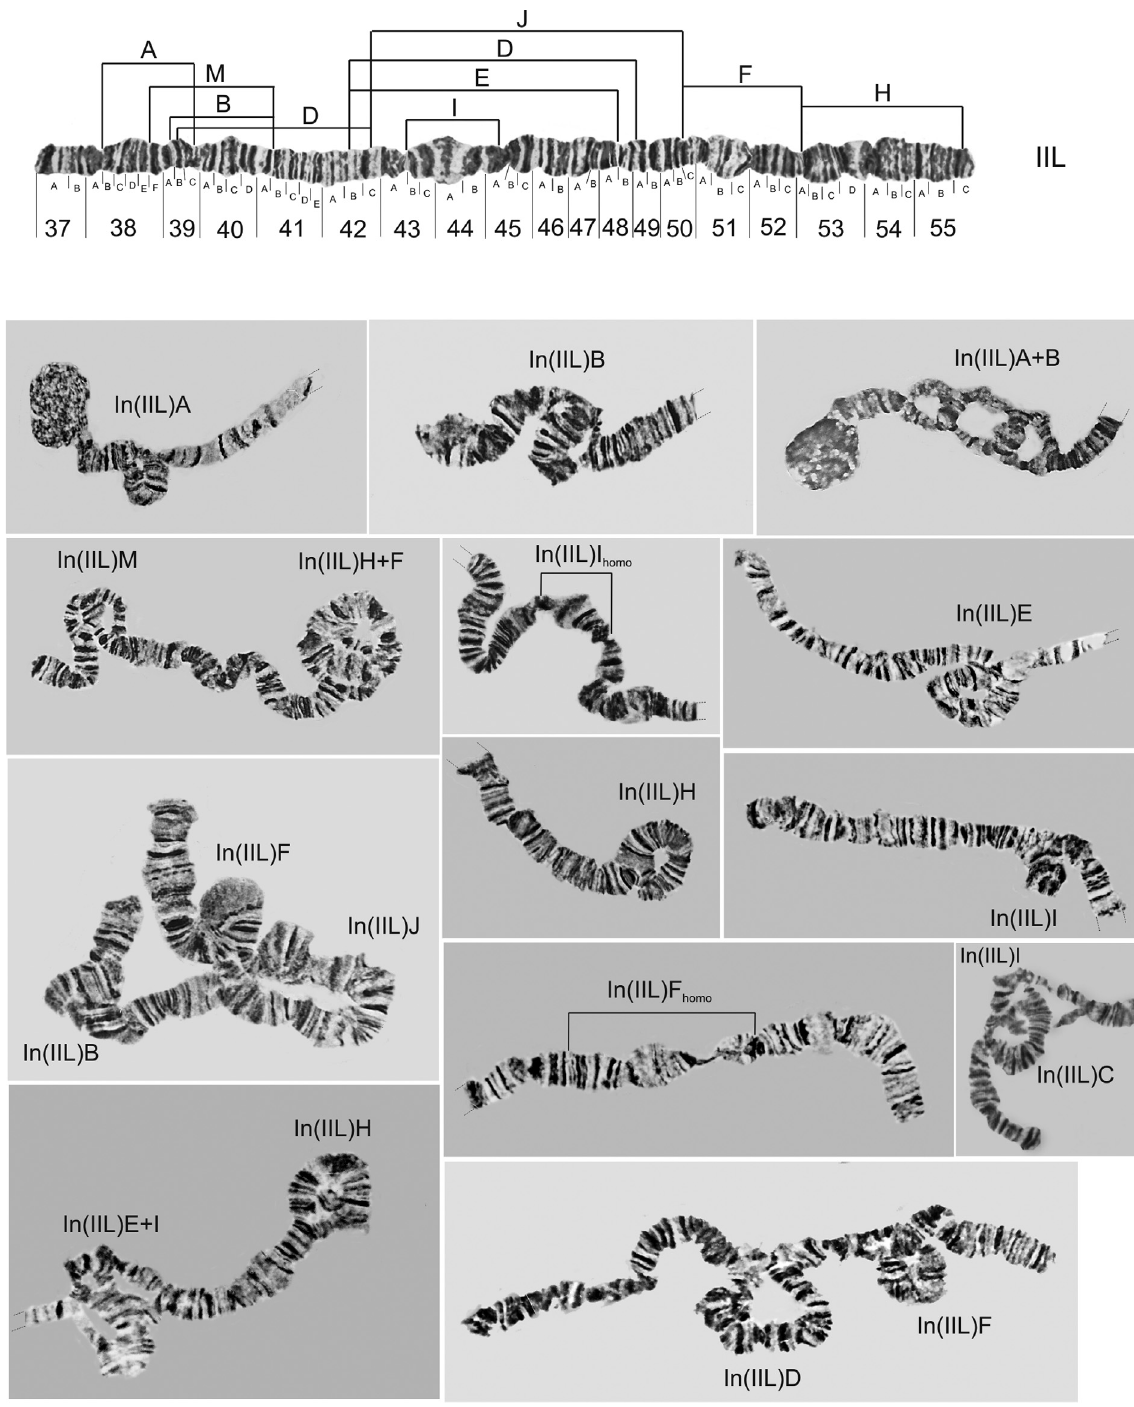
Figure3 -DistributionofinversionbreakpointsobservedonchromosomalarmIILof D.willistoni andphotomicrographsofinversions(inhomoandhet- erozygous state)